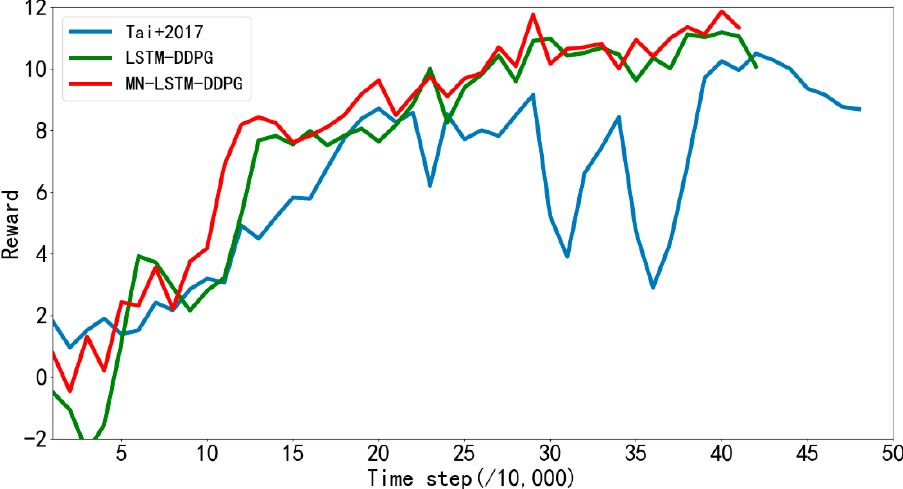
Figure 8. The average rewards returned by reference [31] and the improved algorithm every 10,000 steps during training in simulation Figure 6a.